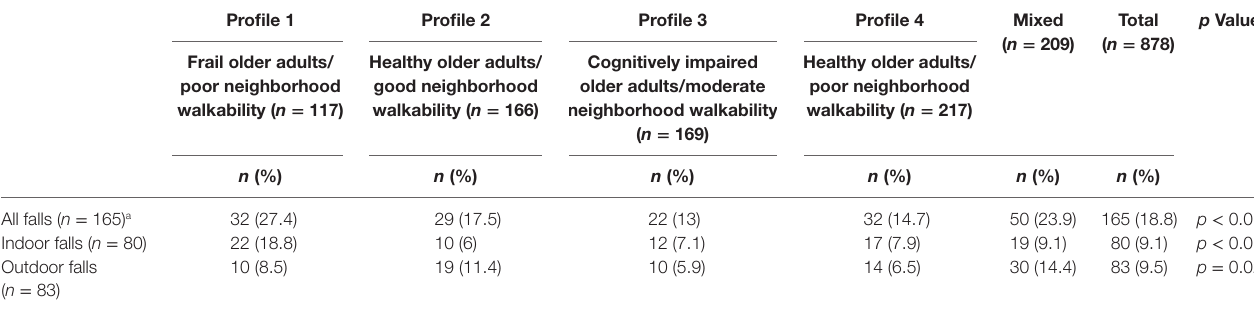
TaBle 3 | Total number of falls past 6 months by